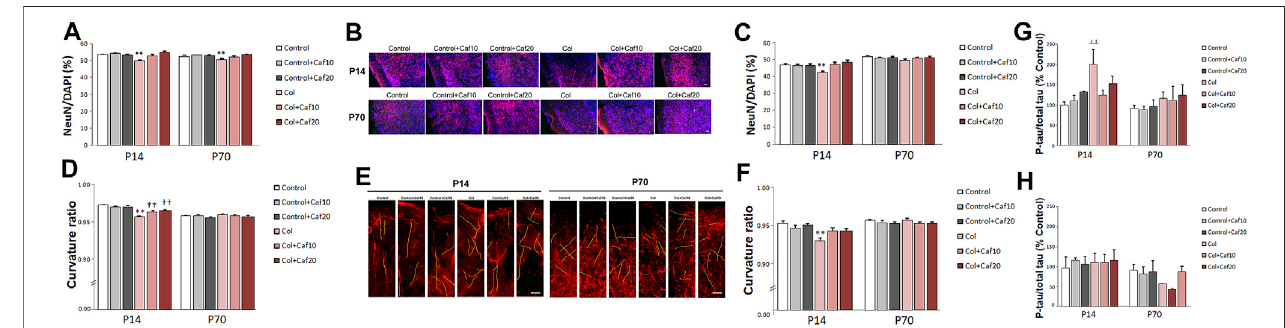
FIGURE3| CafreducesneuronalcompromiseafterGM-IVH. (A) NeuN/DAPIratiowassigni fi cantlyreducedinthecortexfromCol-treatedmice,andCaftreatment reverted this situation at P14 [F (2,271) = 9.53 and p < 0.001; ** p < 0.01 vs. rest of the groups]. Data are representative of 3 – 5 mice (Control n = 4, Control + Caf10 n = 5, Control+Caf20n=5,Coln=3,Col+Caf10n=4,andCol+Caf20n=4).SimilardifferenceswereobservedatP70[F (22,983) =4.45and p =0.012;** p < 0.01vs.restof thegroups].Dataarerepresentativeof3 – 6mice(Controln=6,Control+Caf10n=5,Control+Caf20n=5,Coln=4,Col+Caf10n=4,andCol+Caf20n=3). (B) Representative images of cortical NeuN (red) and DAPI (blue) staining showing that the reduced NeuN/DAPI ratio in GM-IVH animals improves in Caf-treated animals at P14 and P70. Scale bar = 50 µm. (C) NeuN/DAPI ratio was affected in the SVZ at P14 [F (2,420) = 11.82 and p < 0.01; ** p < 0.01 vs. rest of the groups]. Data are representative of 3 – 5 mice (Control n = 4, Control + Caf10 n = 5, Control + Caf20 n = 5, Col n = 3, Col + Caf10 n = 3, and Col + Caf20 n = 3). Differences were no longer detectedatP70[F (2,559) =0.351and p =0.704].Dataarerepresentativeof3 – 6mice(Controln=6,Control+Caf10n=5,Control+Caf20n=5,Coln=4,Col+Caf10n =4,andCol+Caf20n=3). (D) Corticalcurvatureratiowassigni fi cantlyaffectedbyCollesions,andCaftreatmentimprovedthissituationatP14[F (24,048) =16.79and p < 0.01; ** p < 0.01 vs. rest of the groups, †† p < 0.01 vs. Control, Control + Caf10, and Control + Caf20]. Data are representative of 5 – 6 mice (Control n = 5, Control + Caf10 n = 5, Control + Caf20 n = 5, Col n = 6, Col + Caf10 n = 6, and Col + Caf20 n = 5). No differences were observed in any of the groups under study when the curvatureratiowasanalyzedinthecortexatP70[F (23,645) =2.65, p =0.071].Dataarerepresentativeof4 – 5mice(Controln=5,Control+Caf10n=5,Control+Caf20n =4,Coln=5,Col+Caf10n=5,andCol+Caf20n=5). (E) IllustrativeexampleofcorticalSMI-312stainingatP14andP70.Representativeneuritesarelabeledinyellow to highlight neuronal curvature in all groups under study. Scale bar = 15 µm. (F) Curvature ratio was also signi fi cantly affected in the SVZ at P14 [F (21,129) = 7.27 and p = 0.001;** p < 0.01vs.restofthegroups].Dataarerepresentativeof4 – 5mice(Controln=5,Control+Caf10n=5,Control+Caf20n=4,Coln=5,Col+Caf10n=5,and Col + Caf20 n = 5). Neuron curvature ratio was no longer affected in the SVZ at P70 [F (21,016) = 0.269 and p = 0.765]. Data are representative of 4 – 5 mice (Control n = 5, Control+Caf10n=5,Control+Caf20n=3,Coln=5,Col +Caf10 n=5,andCol +Caf20 n=5). (G) Tauphosphorylationwassigni fi cantlyincreasedinthecortexfrom P14miceafterCollesions,andCaftreatmentimprovedthissituationwhencomparedwithControlmice[F (2,30) =3.33and p =0.49; ┴┴ p =0.006vs.ControlandControl + Caf10]. Data are representative of 5 – 7 animals (Control n = 7, Control + Caf10 n = 5, Control + Caf20 n = 5, Col n = 7, Col + Caf10 n = 6, and Col + Caf20 n = 6). Differenceswerenolongerdetectedinthelongterm[F (2,26) =0.016and p =0.984].Dataarerepresentativeof4 – 7animals(Controln=5,Control+Caf10n=5,Control+ Caf20n=4,Coln=7,Col+Caf10n=6,andCol+Caf20n=5). (H) Tauphosphorylationwasnotsigni fi cantlyaffectedinthestriatumfromP14mice[F (2,27) =0.031and p = 0.970]. Data are representative of 5 – 6 animals (Control n = 5, Control + Caf10 n = 5, Control + Caf20 n = 6, Col n = 6, Col + Caf10 n = 5, and Col + Caf20 n = 6). No differences were observed among groups at P70 [F (2,25) = 0.768 and p = 0.474]. Data are representative of 5 – 6 animals (Control n = 5, Control + Caf10 n = 5, Control + Caf20 n = 5, Col n = 5, Col + Caf10 n = 5, and Col + Caf20 n =